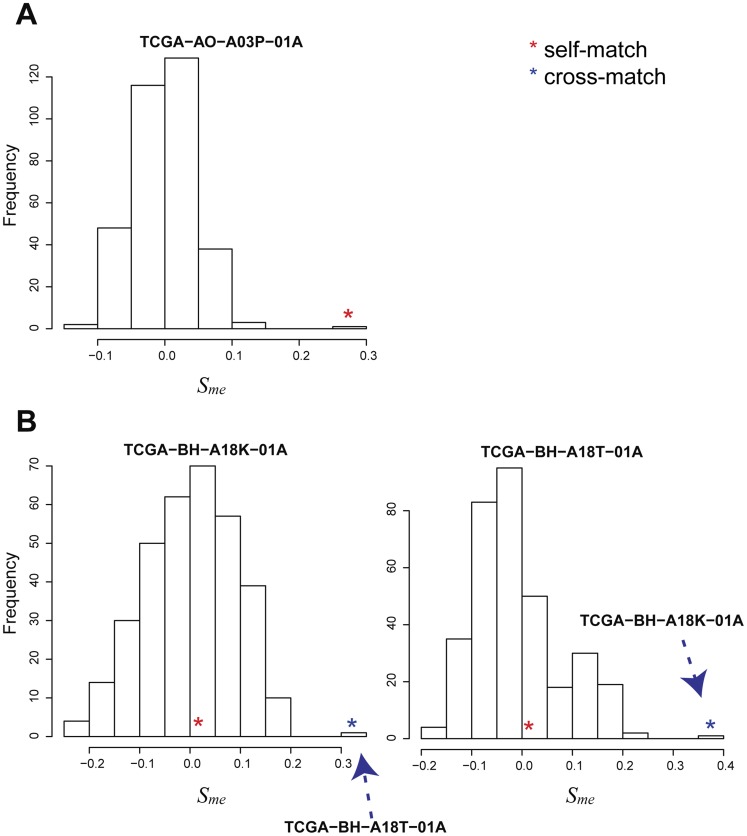
Examples of sample alignment in the TCGA BRCA data set.(A) A similarity score distribution of a correctly labeled profile. The red star indicates the similarity score between self-matched profile pairs (gene expression and methylation data profiles are labeled as pertaining to the same sample). (B) Similarity scores of self-matched pairs (red stars) between gene expression and methylation profiles for two samples are lower than the similarity scores of cross-matched pairs (blue stars).